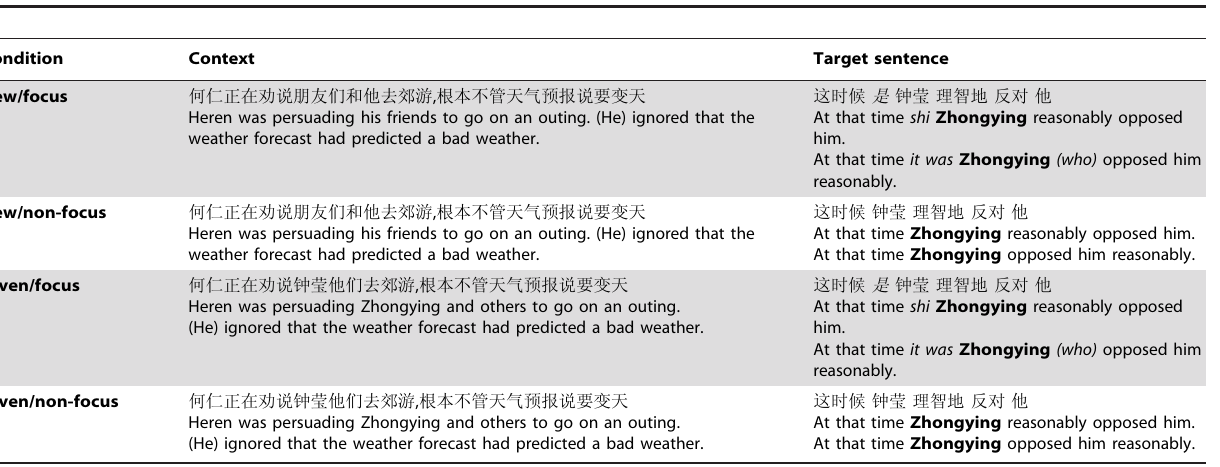
Table 1. An Example of Experimental Materials *